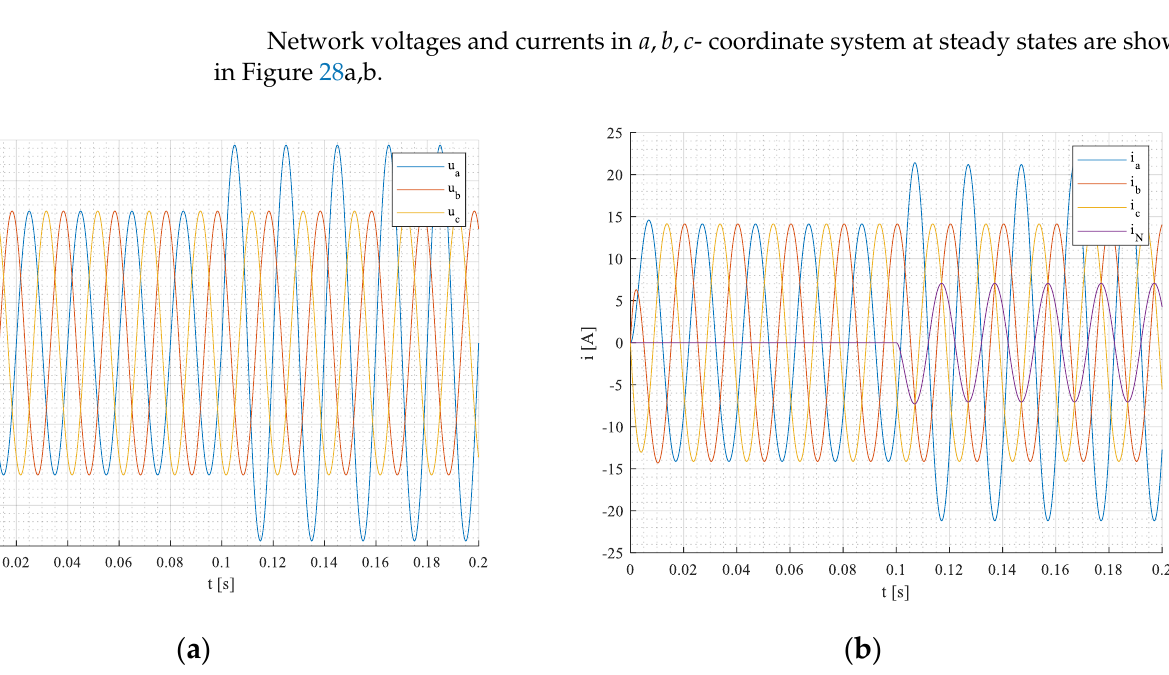
Figure 28. Network voltages ( a ), load, and neutral currents ( b ). Apparent-, active-, blind-, and distortion power components during transient states for a 3-phase system are shown in Figure 29a–d. Zero power component Po is not equal to zero, and it is shown in Figure 30. Unlikely previous cases, the network voltages feature zero-sequence since u a is 33% higher, Figure 28a. Thus, the active power of the load is proportionally higher, Figure 28b, despite the phase current i a and current of neutral I N being in antiphase as in a non- symmetrical load case. So, this time the zero-sequence component Po is not zero, and it shows a little bit more than 50 W, Figure